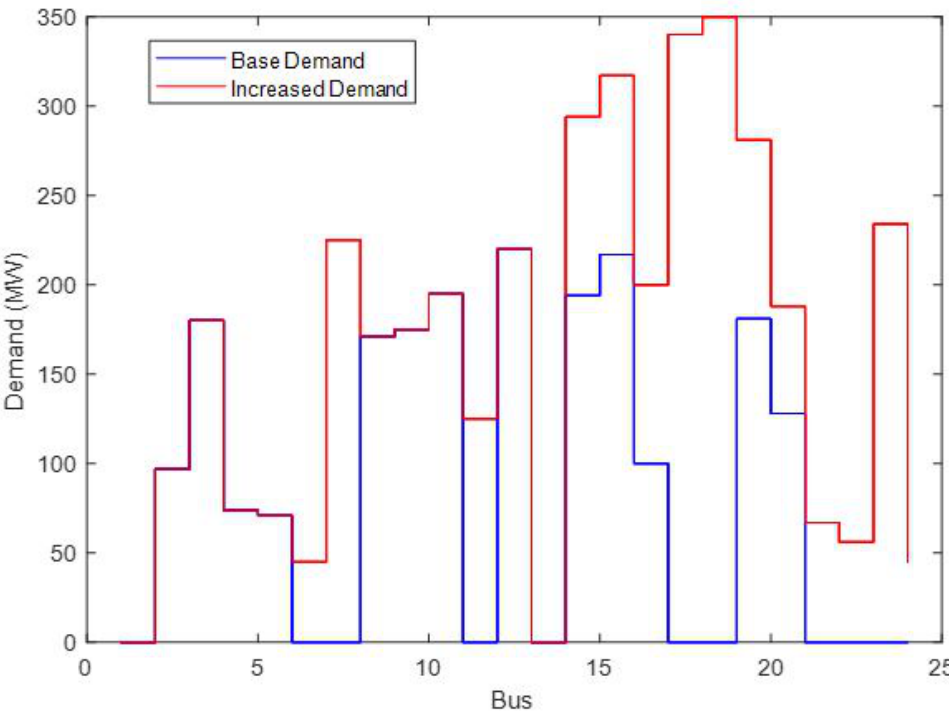
Figure 5. The 24-bus system’s load profile in base and increased demand scenarios. Table 8. The 24-bus system—the base year demand versus increment in energy demand. Original Demand ( MW ) Increased Demand ( MW